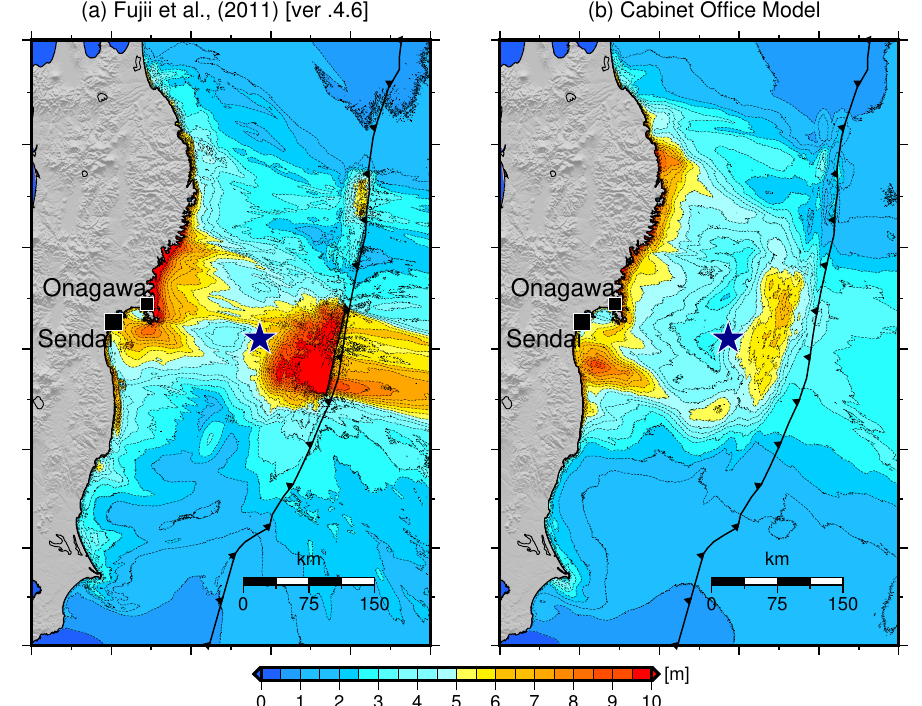
Figure 5. (a) Maximum tsunami heights computed using the tsunami source proposed by Fujii et al. [1] (model A). ( b ) Maximum tsunami heights estimated using the spatio-temporal earthquake source from the Cabinet Office Model [9] (model